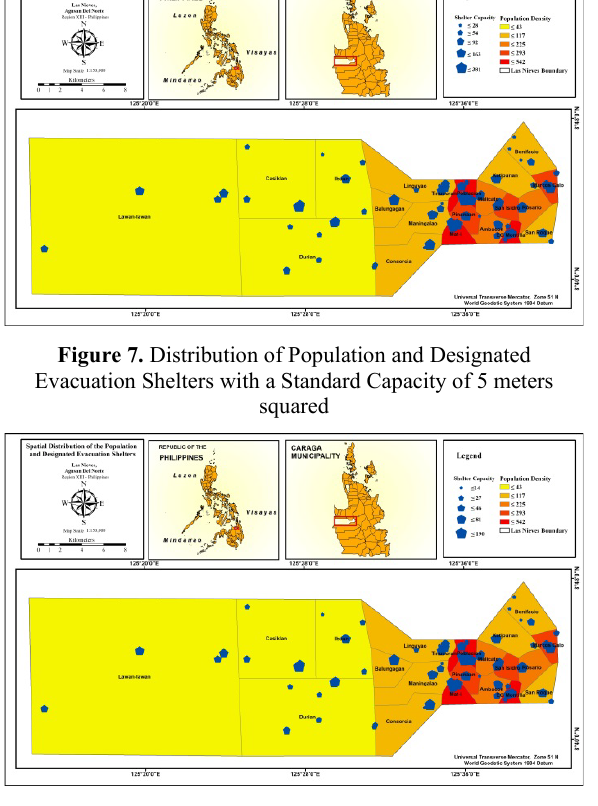
Figure 8. Distribution of Population and Designated Evacuation Shelters with a Standard Capacity of 10 meters Figure 6. Assessment of Evacuation Shelters with (a) 2-Year Flood Event (b) 10-Year Flood Event, and (c) 100-Year Flood Event